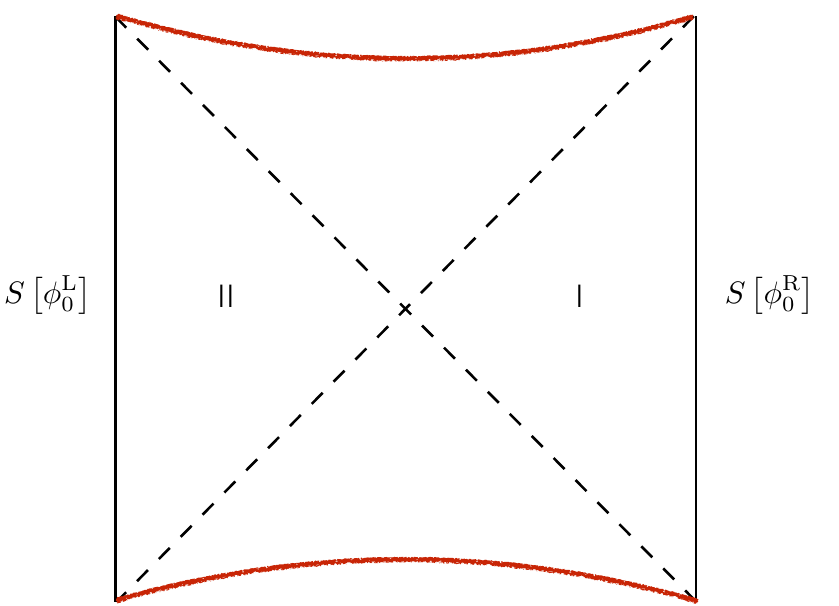
Figure 1 . The maximally extended geometry for an eternal black hole in AdS. This represents a pure state in which the complete dual CFT is a tensor product of the two CFTs, de(cid:12)ned on the left and the right